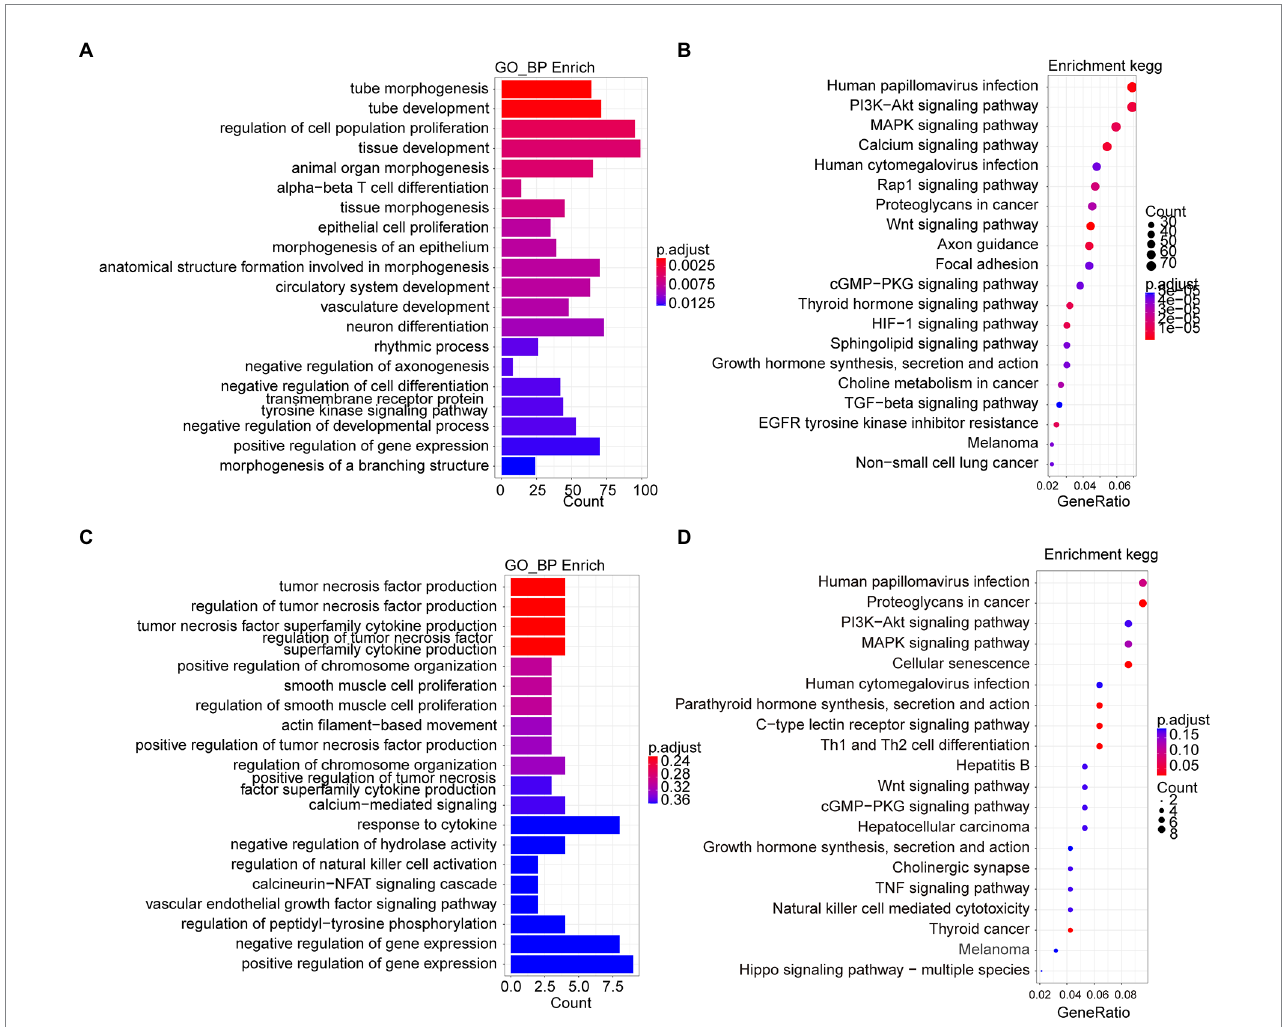
FIGURE 4 Go and KEGG enrichment analyses from ATAC-seq dataset reveal mechanism of antibacterial process of L. reuteri . (A,B) GO and KEGG enrichment analyses between E. coli F18ac and control groups. (C,D) GO and KEGG enrichment analyses between E. coli F18ac with and without L. reuteri groups. Enriched genes were annotated by DARs from